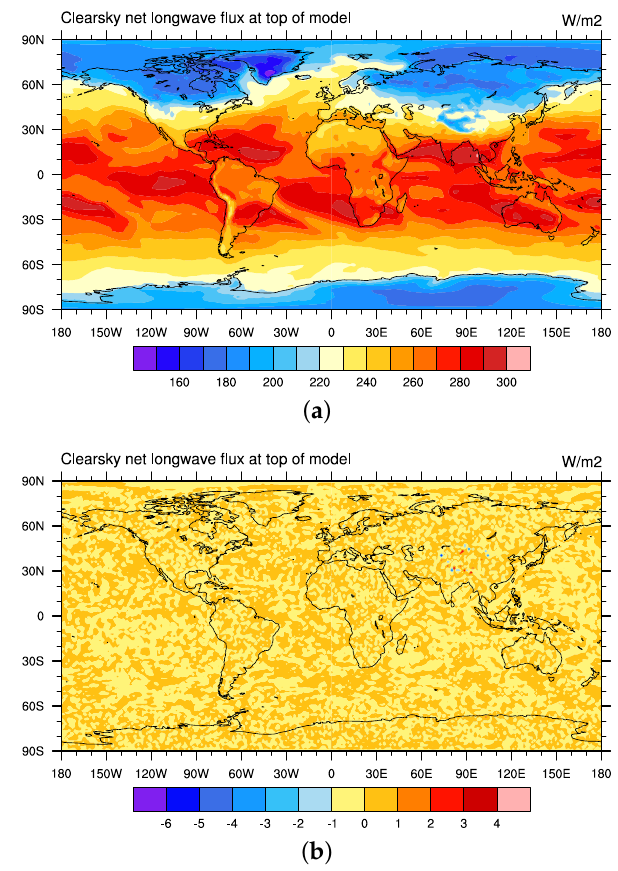
Figure 7. Impact on the longwave flux at the top of the atmosphere in a clear sky. ( a ) Longwave flux simulated by the CAS-ESM RRTMG_LW on the CPU; ( b ) Longwave flux differences between the simulations running the CAS-ESM RRTMG_LW only on the CPU and running the CAS-ESM RRTMG_LW on the